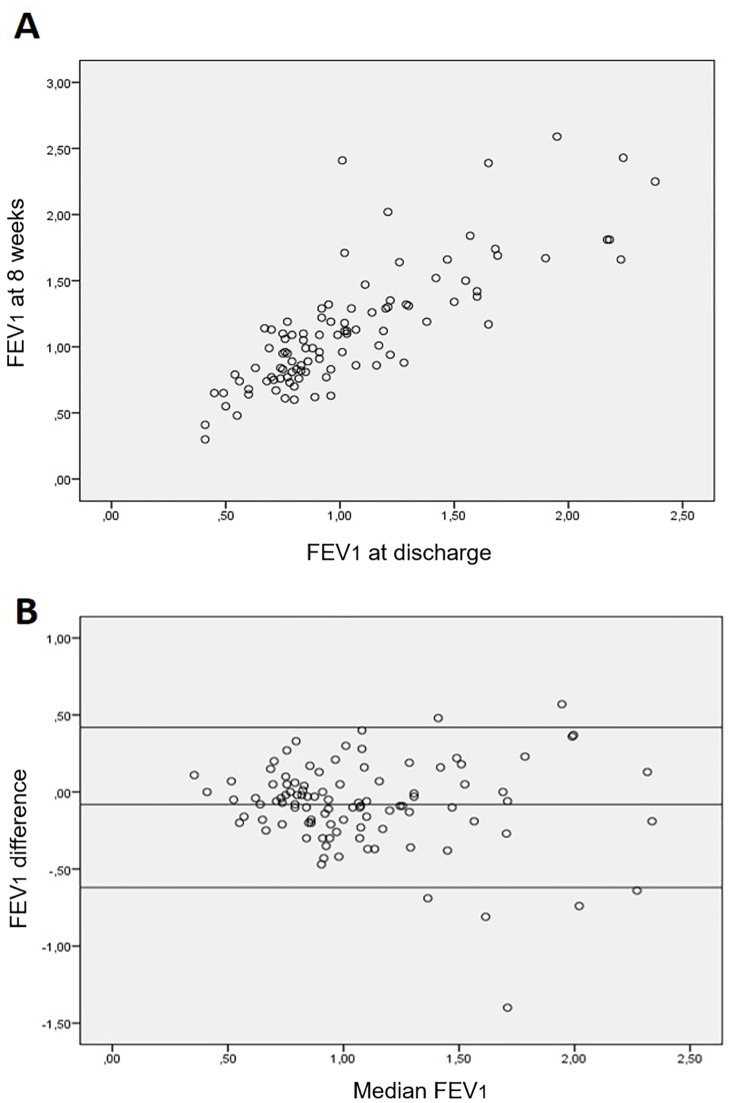
Correlation between FEV1 at discharge and 8 weeks.A. Linear correlation. B. Bland-Altman graph.